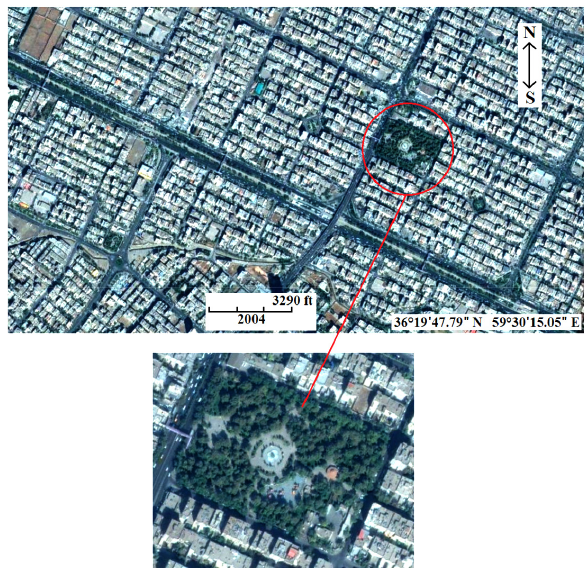
Figure 1. The urban park (Golha) in Mashhad City, Google earth software